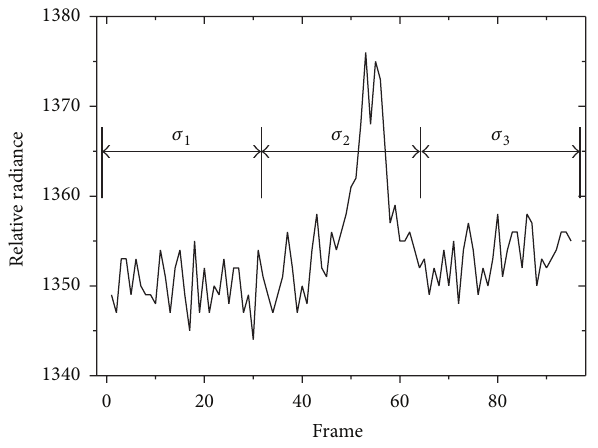
Figure 9: Background variance